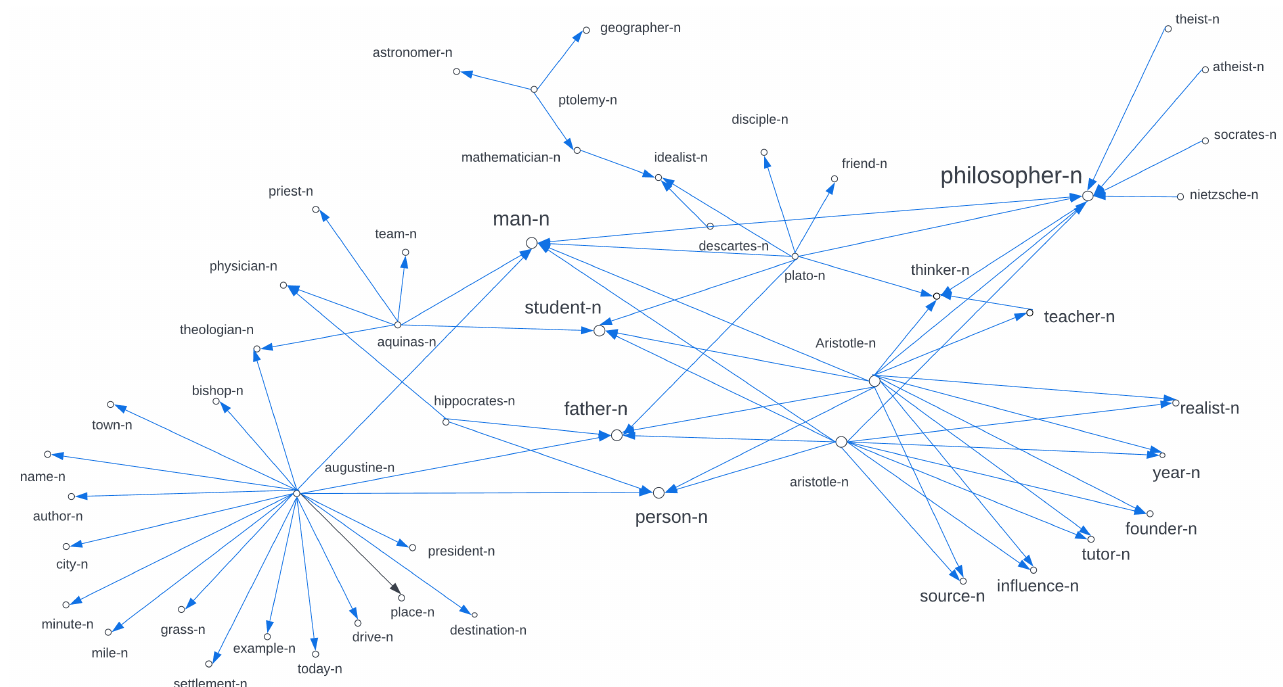
Figure 3. Semantic class labeling of FoF [ and | or ] ethics associated community 1 of the ConGraCNet graph of the source lexeme ethics-n , FoF ethics , in enTen-